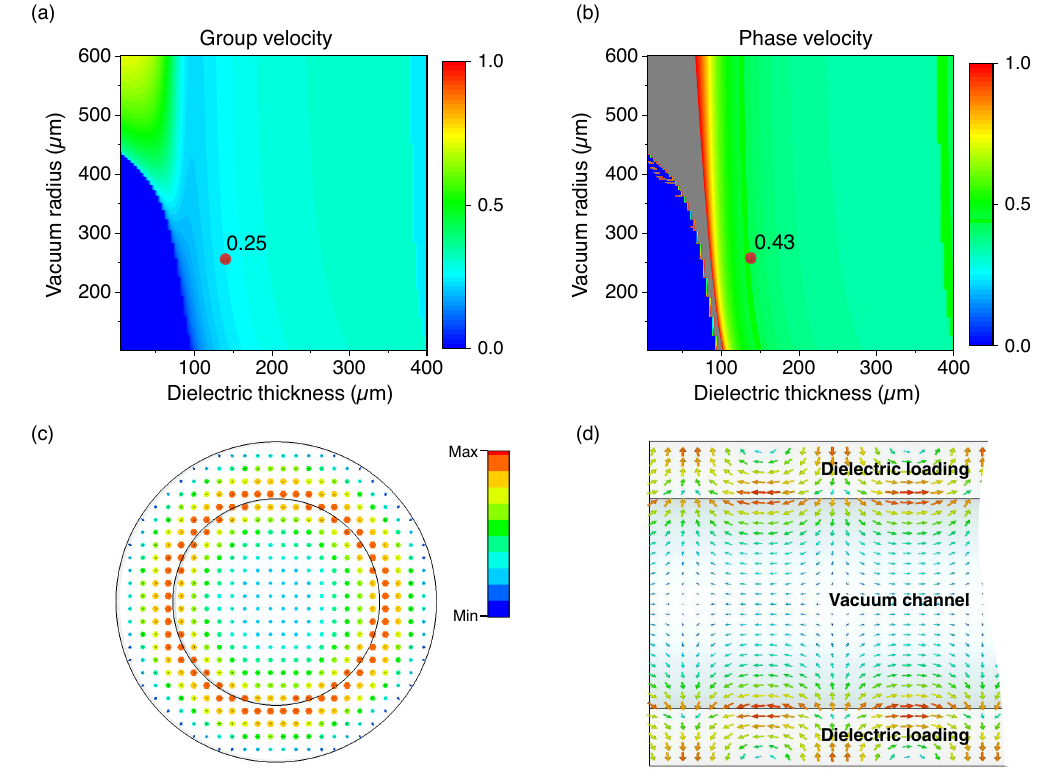
FIG. 2. TM 01 — mode parameters of DLW. Group (a) and phase (b) velocity of the TM 01 mode at 260 GHz in a circular copper waveguide with dielectric loading. The red dots represent the design point for electron beam manipulation with 250 μ m vacuum radius and 140 μ m dielectric thickness. Transverse (c) and longitudinal (d) cross section of the electric field distribution at TM 01 mode with 43% phase velocity at the design parameter for the experiment simulated with CST M icrowave S tudio [36]. The dielectric wall thickness is 140 μ m, and the vacuum channel diameter is 510 μ